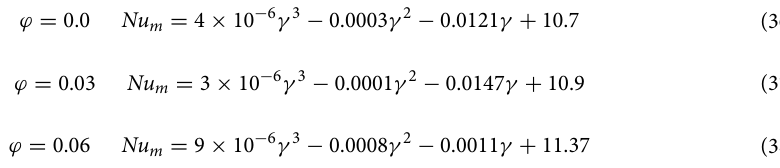
The Bejan number in various nanofluid concentrations and cavity angles at Ra = 10 5 , ω = 0, Ha = 20, Rd = 1 are plotted in Fig. 17. As seen, the Bejan number rises with increasing nanofluid concentration. This increase occurs for all cavity angles, but it is larger for some angles and smaller for other angles. The temperature gradient rises with increasing nanofluid concentration, consequently, the thermal contribution of S total increases leading to a rise in the Be number. As shown, for various cavity angles that the Bejan number is smaller when heat transfer